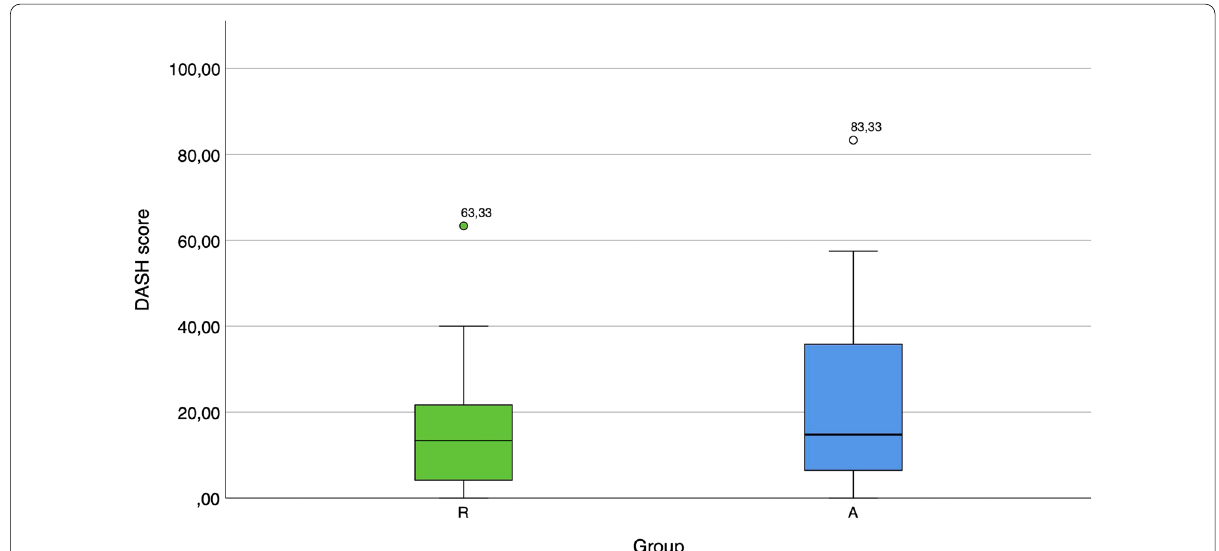
Fig. 7 Boxplots presenting the DASH scores in groups R and